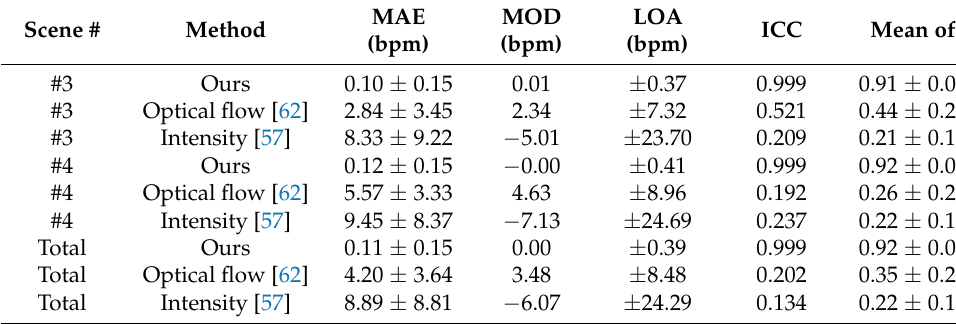
Table 6. Respiration measurements in environments with motion noise.